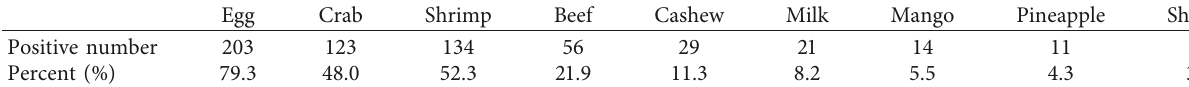
Table 2: Allergic reactions on food-specific IgE of food.